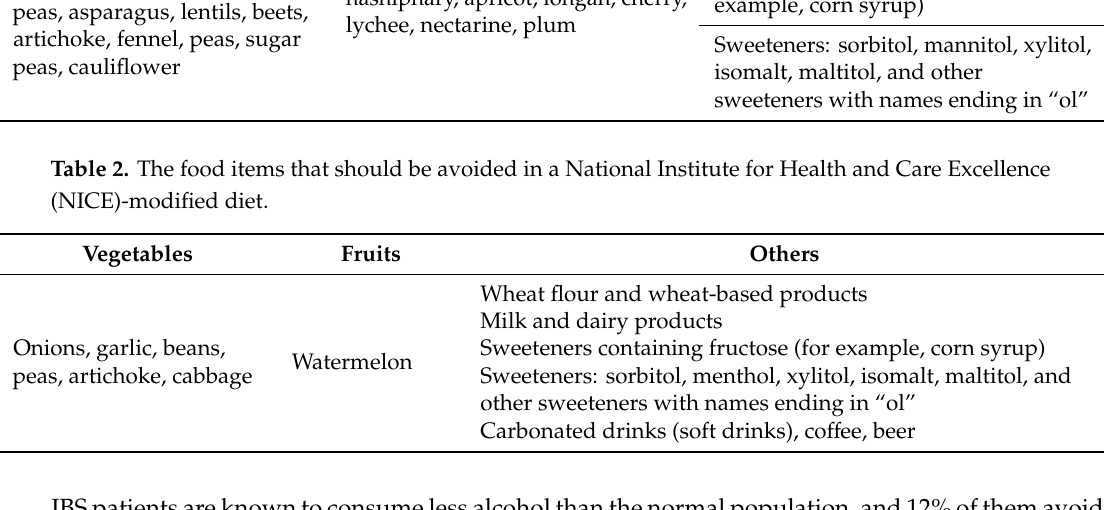
Table 1. Food items rich in fermentable oligo-, di-, monosaccharides, and polyols (FODMAPs). Vegetables Fruits Others Onions, garlic, the white portion of leeks and spring mushrooms, beans, red kidney beans, Brussels sprouts, sugar artichoke, fennel, peas, sugar peas, cauliflower